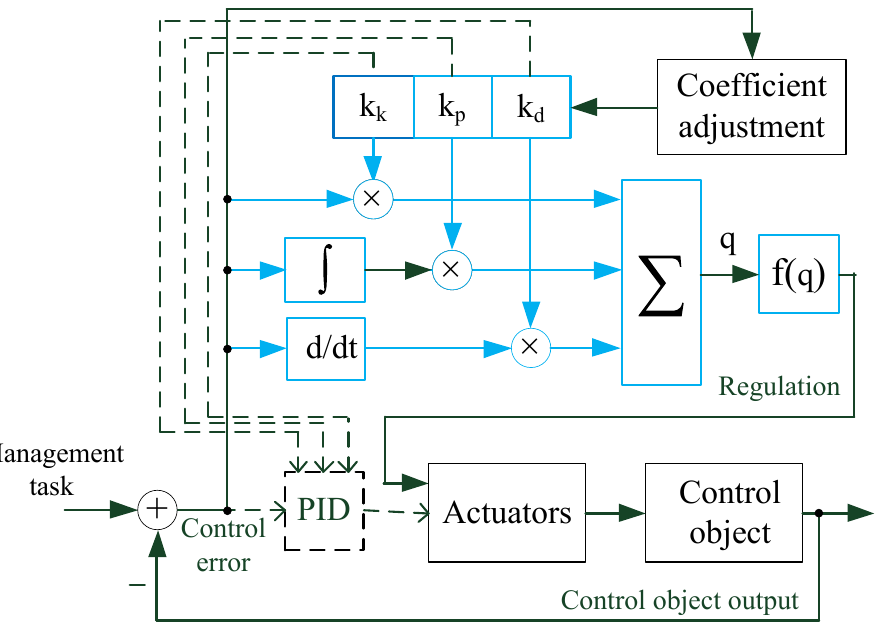
Figure 3. Control channel architecture with an artificial PID neuron.